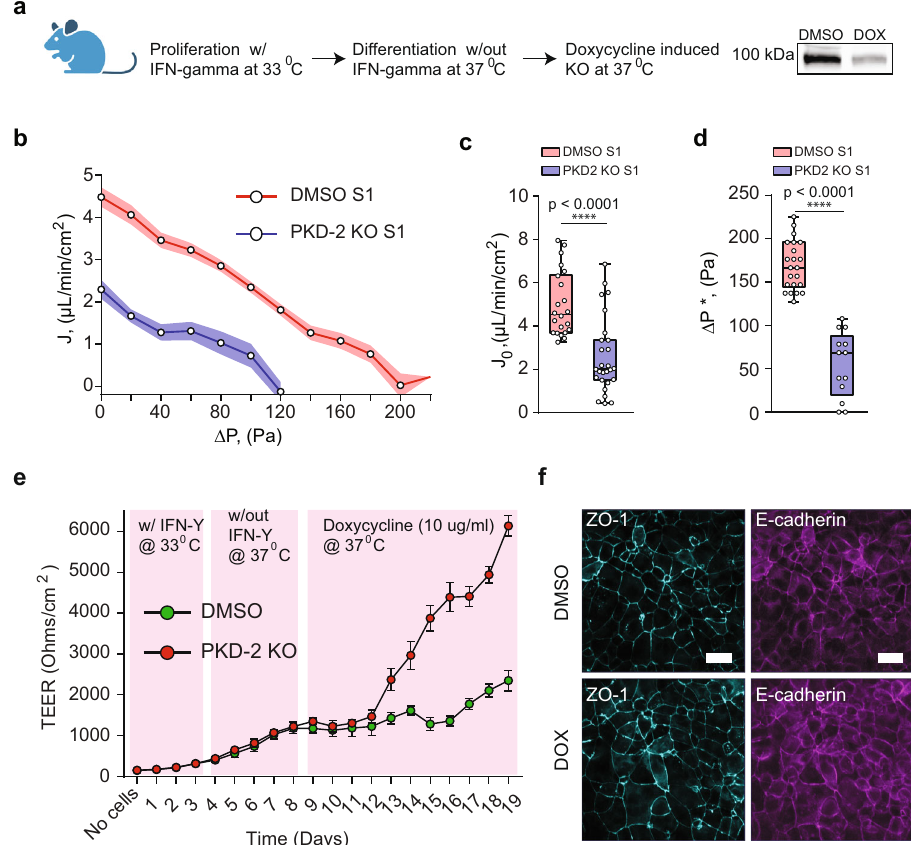
Fig. 5 PKD2 KO in mouse kidney cells decreases fl uid pumping and increases the barrier strength. a Protocol for genetic knock-out in a Pkd2 fl / fl , Pax8rtTA, TetOCre mouse cell line. Western blot showing depletion of polycystin-2 protein in doxycycline (Dox) treated cells. b PPCs for normal ( n = 22, N = 3) vs Pkd2 KO ( n = 27, N = 3, devices, biological repeats) mouse kidney epithelium. Shaded area is the SEM. Comparison of J normal ( n = 22, N = 3) vs. Pkd2 KO ( n = 27, N = 3, devices, biological repeats) mouse kidney epithelium. **** p < 0.0001. (Unpaired, two-tailed, standard t -test). See Fig. 1 caption for explanation of box-plot. e Trans-epithelial electrical resistance (TEER) was measured in mouse cells grown on